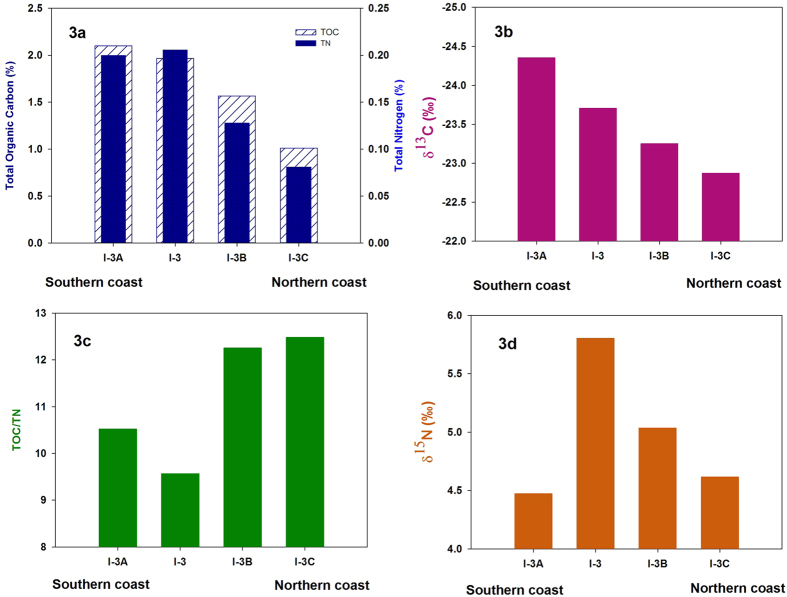
(a) TOC and TN, (b) δ13C, (c) TOC/TN and (d) δ15N variability across the fjord axis at station I-2. Note the similarity in gradient of SOM concentration and its carbon and nitrogen isotopic concentration along and across the fjord axis.